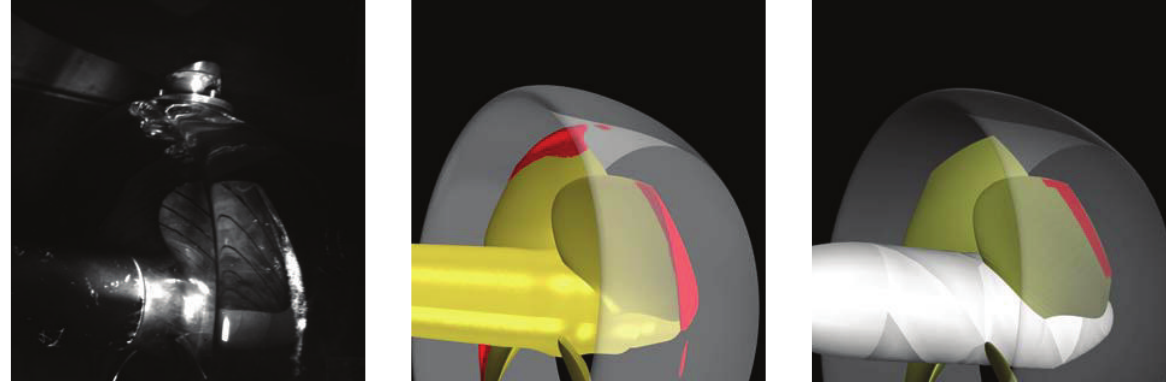
Figure 18: Observed and predicted (RANS and panel method) cavity extension. 130% of the design thrust coe ffi cient at the design cavitation